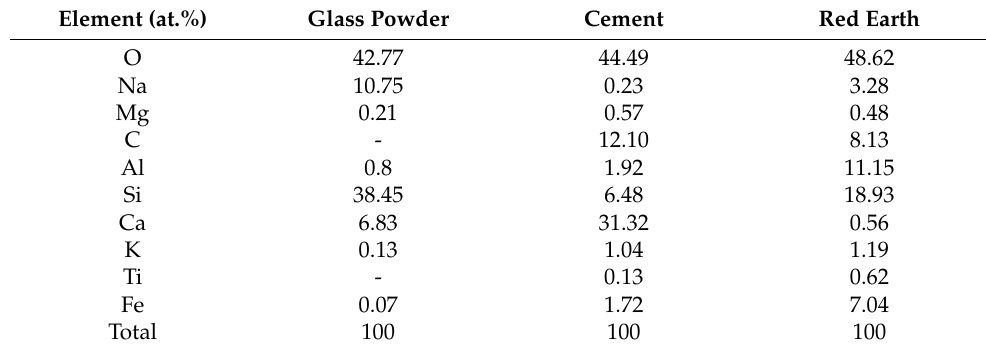
Table 1. Chemical composition of glass powder, cement and red earth. Element (at.%)